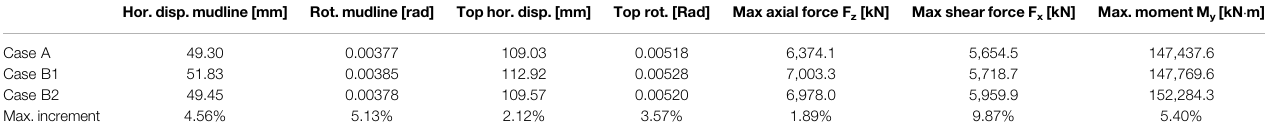
TABLE 5 | Displacement and internal force under the serviceability limit state (SLS).